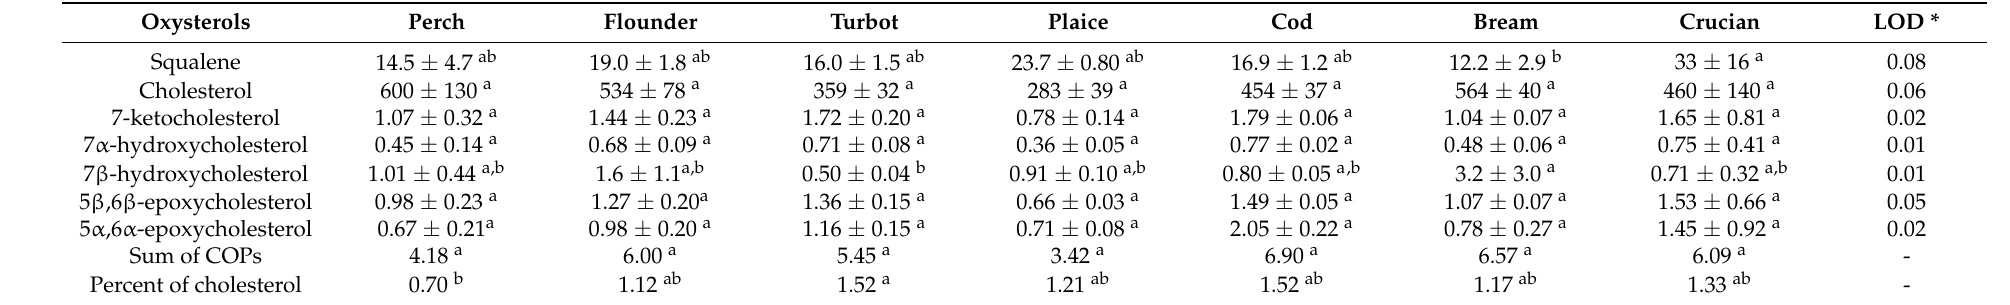
Table 5. The concentration of oxysterols in the fish muscle of selected fish species (mean ± SD) ( µ g/g). Oxysterols